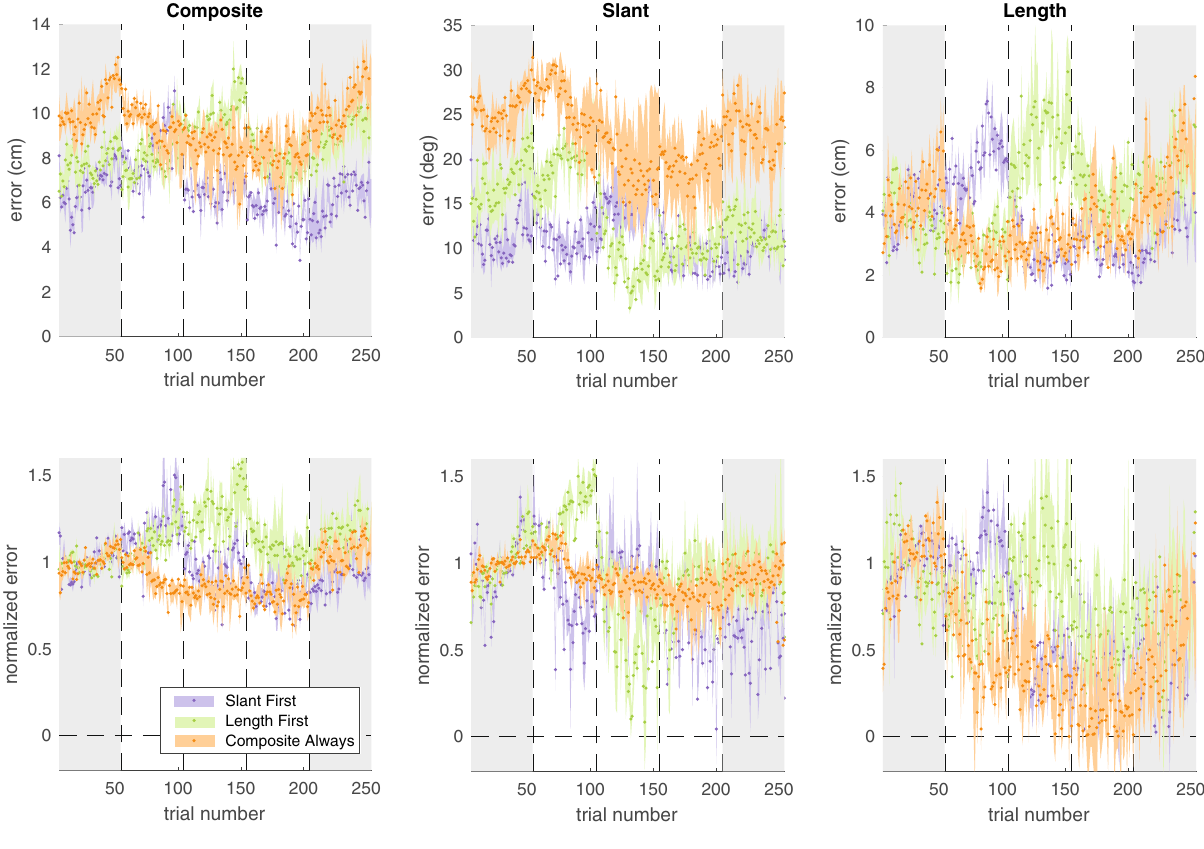
Figure 2. Median time course of errors across groups. Top row: absolute errors. Bottom row: normalized errors. Shaded errors represent the bootstrapped 95% confidence interval of the